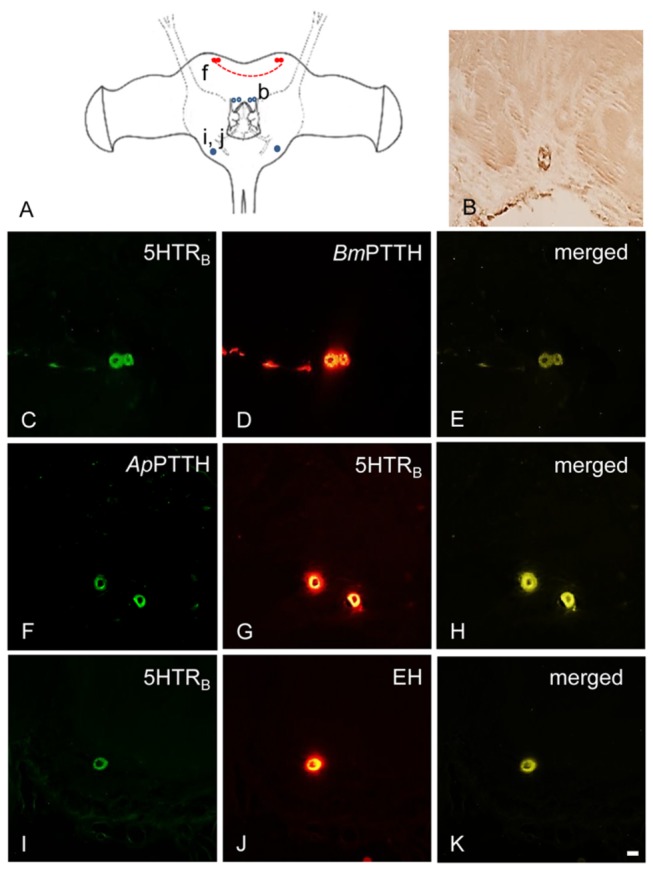
Colocalization of 5HTRB- and PTTH-ir in the adult BR-SOG of
A. pernyi. BmPTTH-ir/ApPTTH-ir in the DL region of protocerebrum of female adult less than one day old was co-localized with Ap5HTRB-ir (red filled circles). EH-ir in the adult brain of A. pernyi and its colocalization with Ap5HTRB-ir (blue filled circles) and unique distribution (open circles) of EH-ir in other regions of the brain. (A) The location of detected cells. Lower-case letters correspond to the regions shown in the photographs (e.g., b to B). (B) Two pairs BmEH-ir cells in the DC region. (C, G) 5HTRB-ir in the DL region. (D) BmPTTH-ir in the DL region. (E) Merged image of BmPTTH-ir and 5HTRB-ir in the DL region. (F) ApPTTH-ir in the DL region. (H) Merged image of ApPTTH-ir and 5HTRB-ir in the DL region. (I) A 5HTRB-ir cell in the SOG. (J) One BmEH-ir cell in the SOG. (K) Merged image of BmEH-ir and 5HTRB-ir in the SOG region. Scale bar = 100 µm.